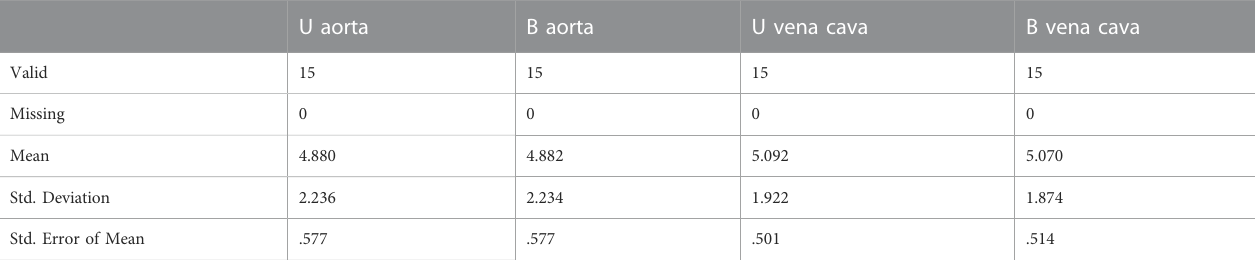
TABLE 1 Descriptive statistics.